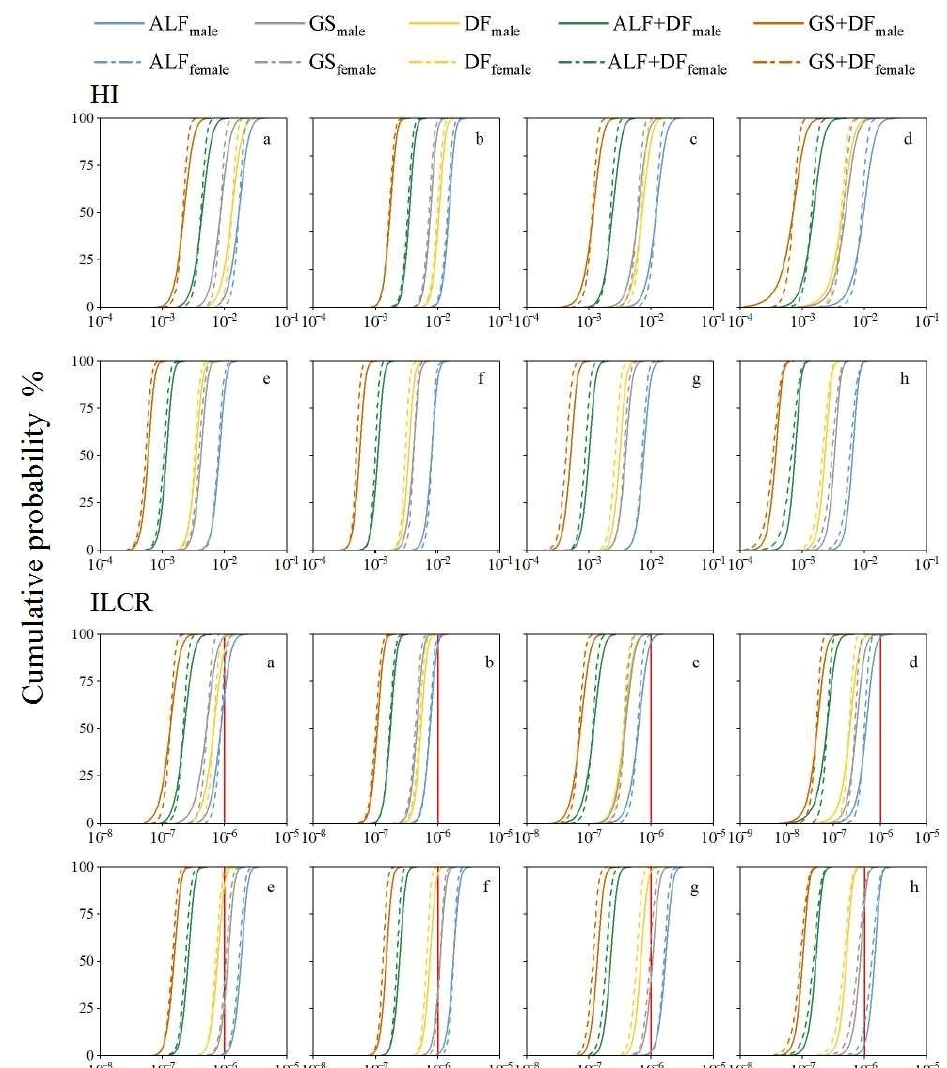
Figure 4. The cumulative probability distribution curve of HI and ILCR for different age groups. ALF: artificial lysozyme fluid, represents the result of acidic simulated lung fluid (pH = 4.5 ± 0.1); GS: Gamble solution, represents the result of neutral simulated lung fluid (pH = 7.4 ± 0.2). DF: represents the result of PM 2.5 deposition fraction; ALF + DF: the result of PM 2.5 deposition dissolved in the ALF; GS + DF: the result of PM 2.5 deposition dissolved in GS. The solid line represents males, and the broken lines represent females. ( a ) represents 2–5-year-old group; ( b ) represents 5–7-year-old group; ( c ) represents 7–11-year-old group; ( d ) represents 11–23-year-old group; ( e ) represents 23–30-year-old group; ( f ) represents 30–40-year-old group; ( g ) represents 40–65-year-old group; ( h ) represents 65–96-year-old group. The solid red line indicates the value of potential carcinogenic risk.